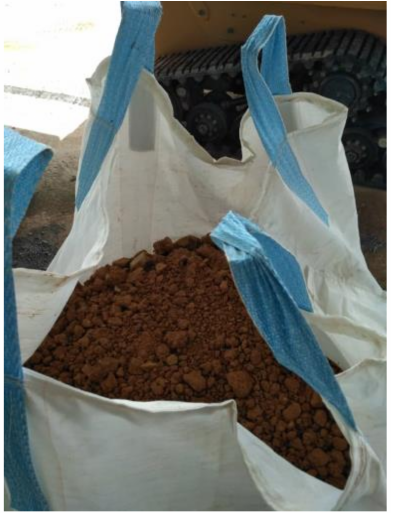
Figure 1. Gypsum waste from chemical